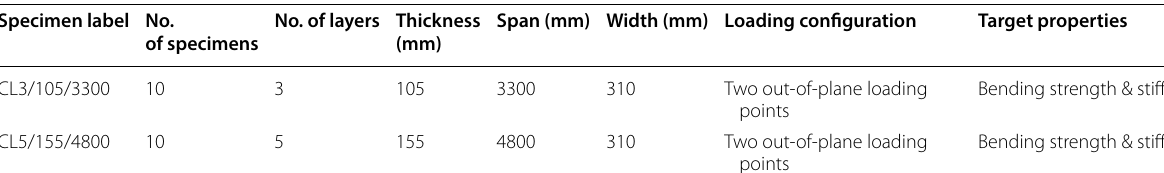
Specimen label No.